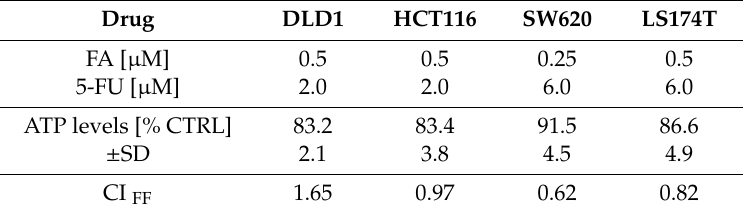
Table 2. E ffi cacy and combinatory index (CI) of FA / 5-FU (FF) and FF / OX / SN in CRC